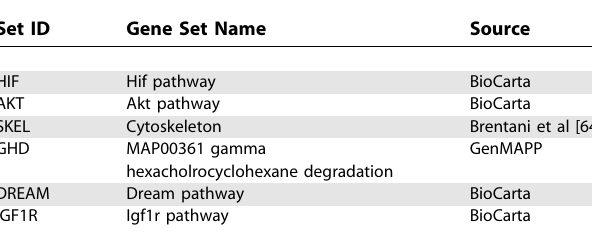
Table 7. Gene Set Names for the Gene Set IDs in Figure